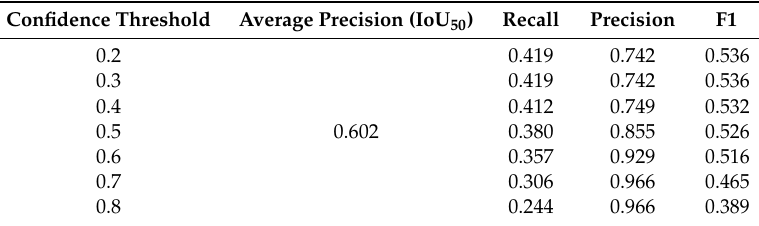
Table 1. Model performance metrics.